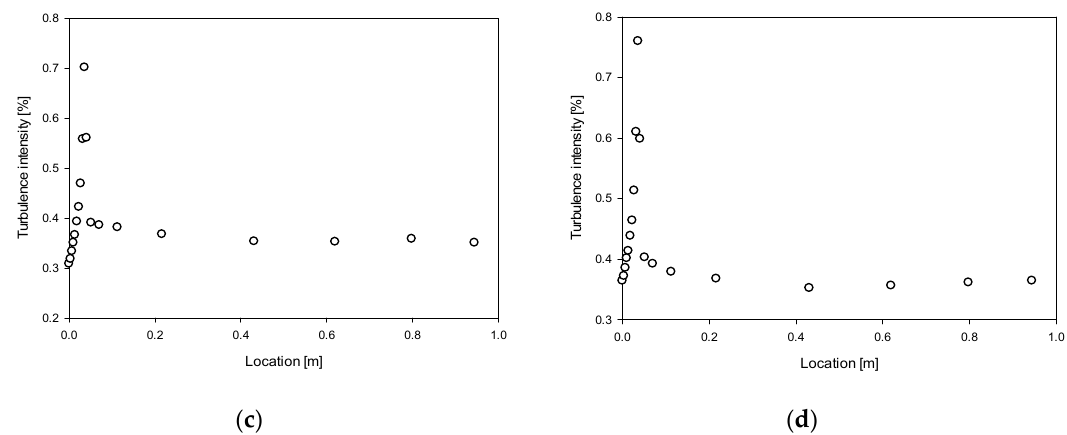
Figure 6. The turbulence intensities obtained by renormalization group (RNG) model at different times: ( a ) 150 s, ( b ) 250 s, ( c ) 350 s, ( d ) 500 s (Location 0: discharging point).